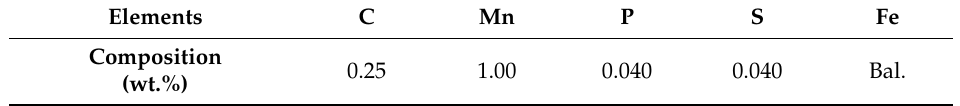
Table 1. Chemical composition of carbon steel pipe used in the district heating system.